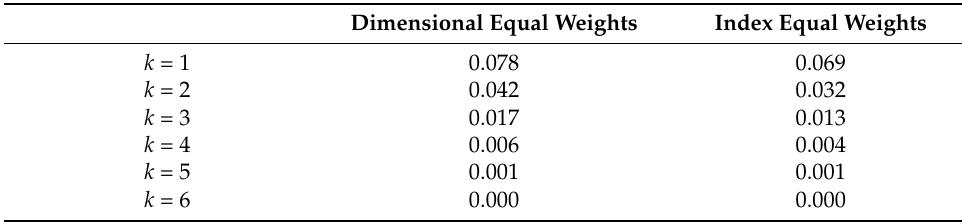
Table 2. Index measurement results of multidimensional poverty of farmers.